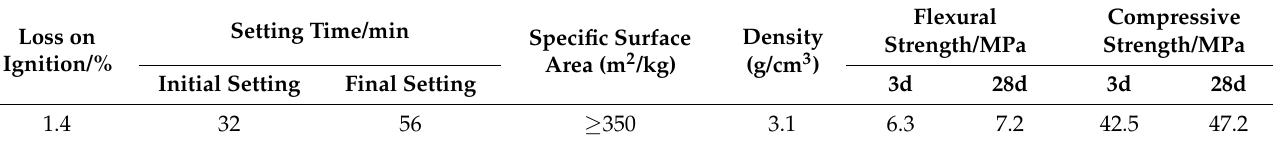
Table 1. Physical property of SAC.